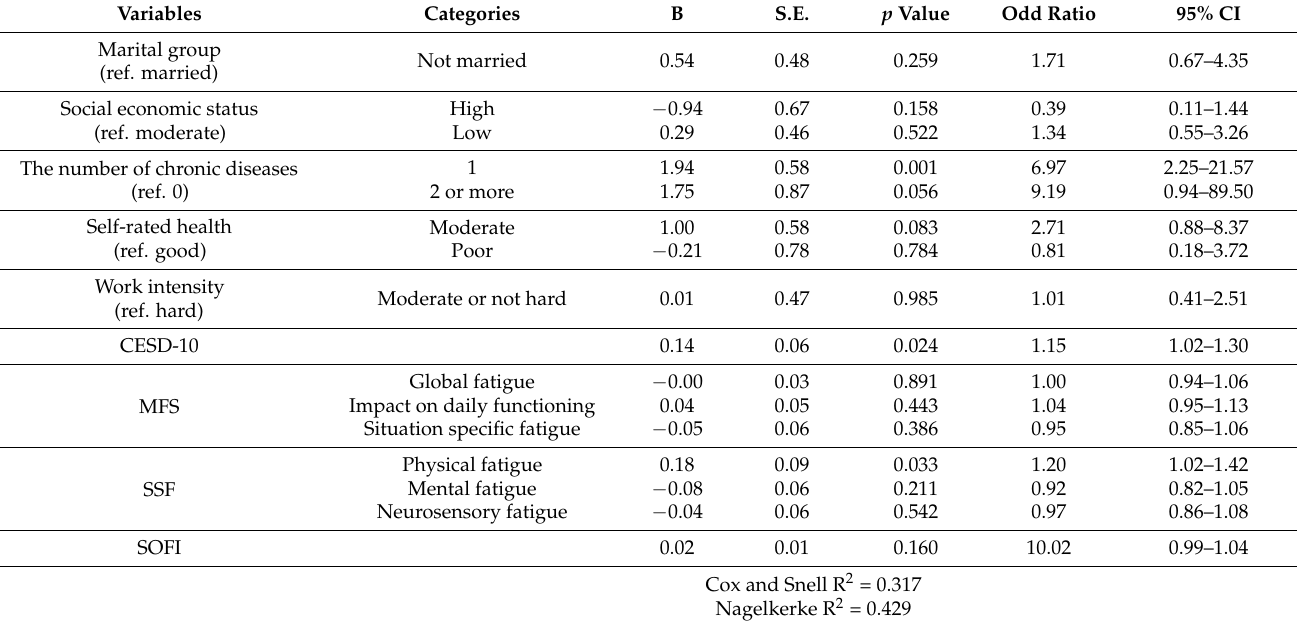
Table 4. Multivariate binomial logistic regression analysis with the two sleep quality groups ( N =